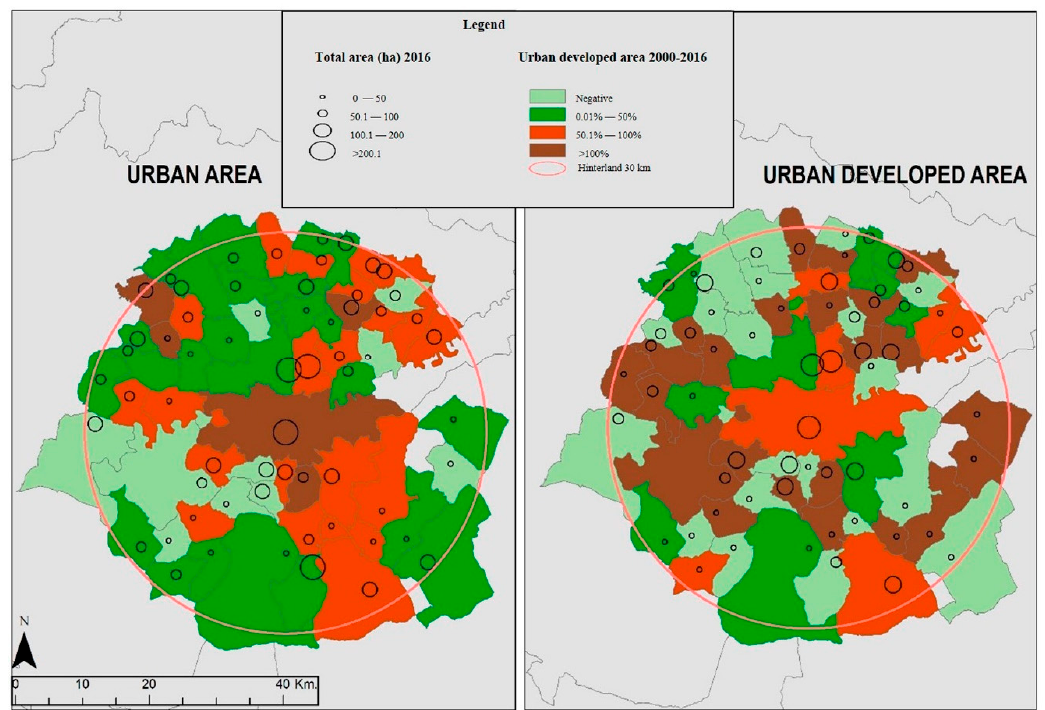
Figure 3. Total of urban area and urban developed area in 2016 and growth rates between 2000 and 2016 in the hinterland within a radius of 30 kilometers in Toledo. Source: Land Registry [64] and self-